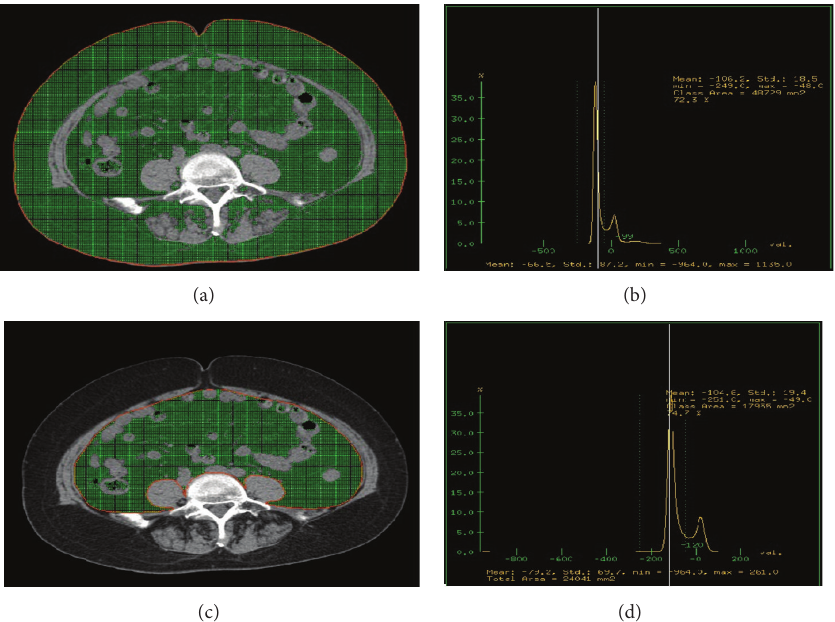
Figure 1: (a)–(d) are the measurement for abdominal fat. (a) is the line along abdominal skin at the axial position of CT image (red line); (b) is the area within adipose tissue of this area with histogram calculation (green area), that is, the total abdominal adipose tissue (TA) (mm 2 ); (c) is the line along the abdominal wall and the internal edges of bilateral psoas major (red line); (d) is the area of adipose tissue within this area with histogram calculation (green area), the visceral adipose tissue (VA) (mm 2